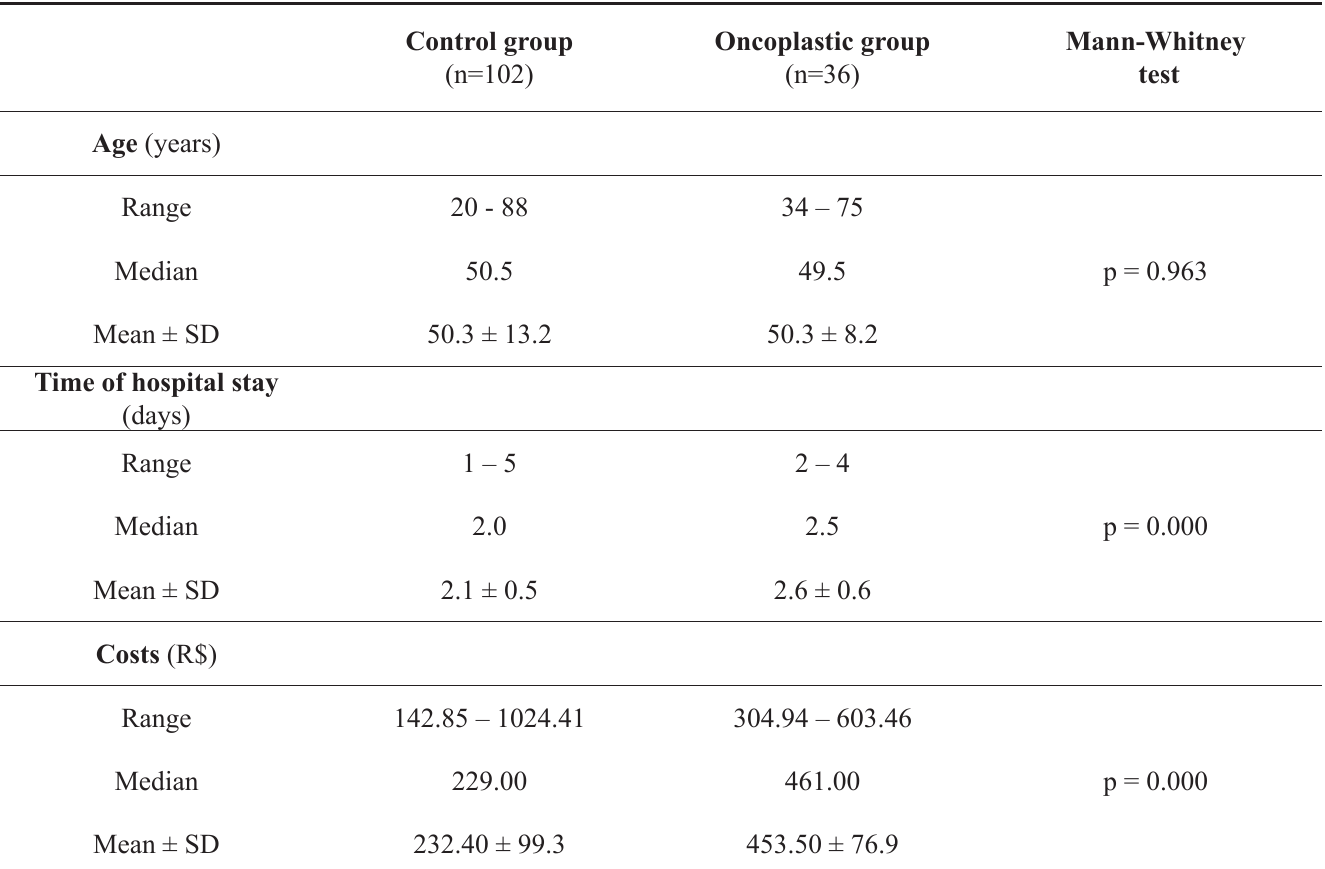
TABLE 1 - Comparison of control and oncoplastic groups in regard to age, time of hospital stay and direct costs.